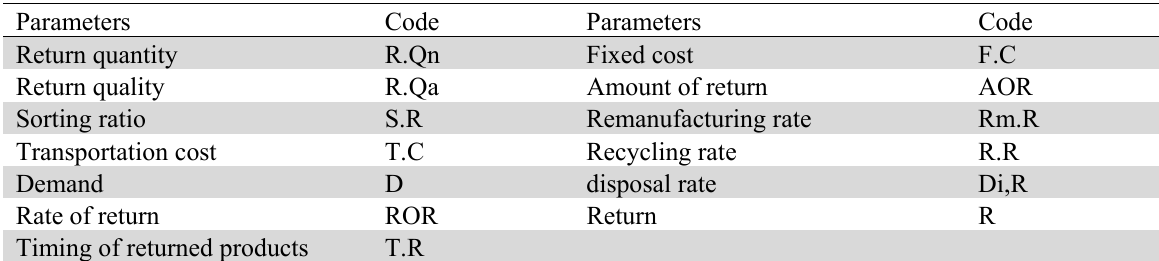
Parameters codes